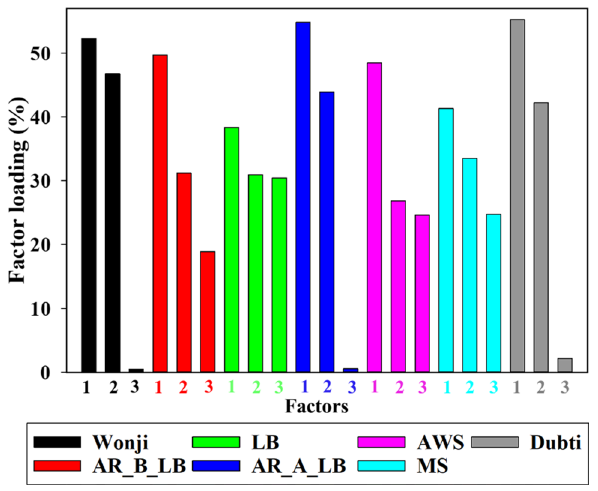
Fig. 8 Variances (factor loadings) explained by each of the three fac- tors in all sampling